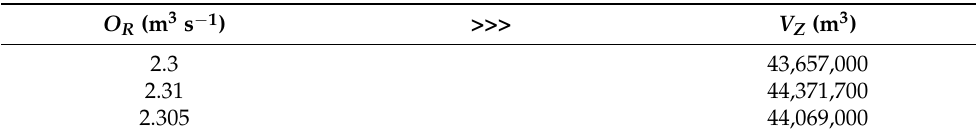
Table 2. O R results for varying input O R and R T ≥ 99.5% for the updated data regarding water inflow into the reservoir.